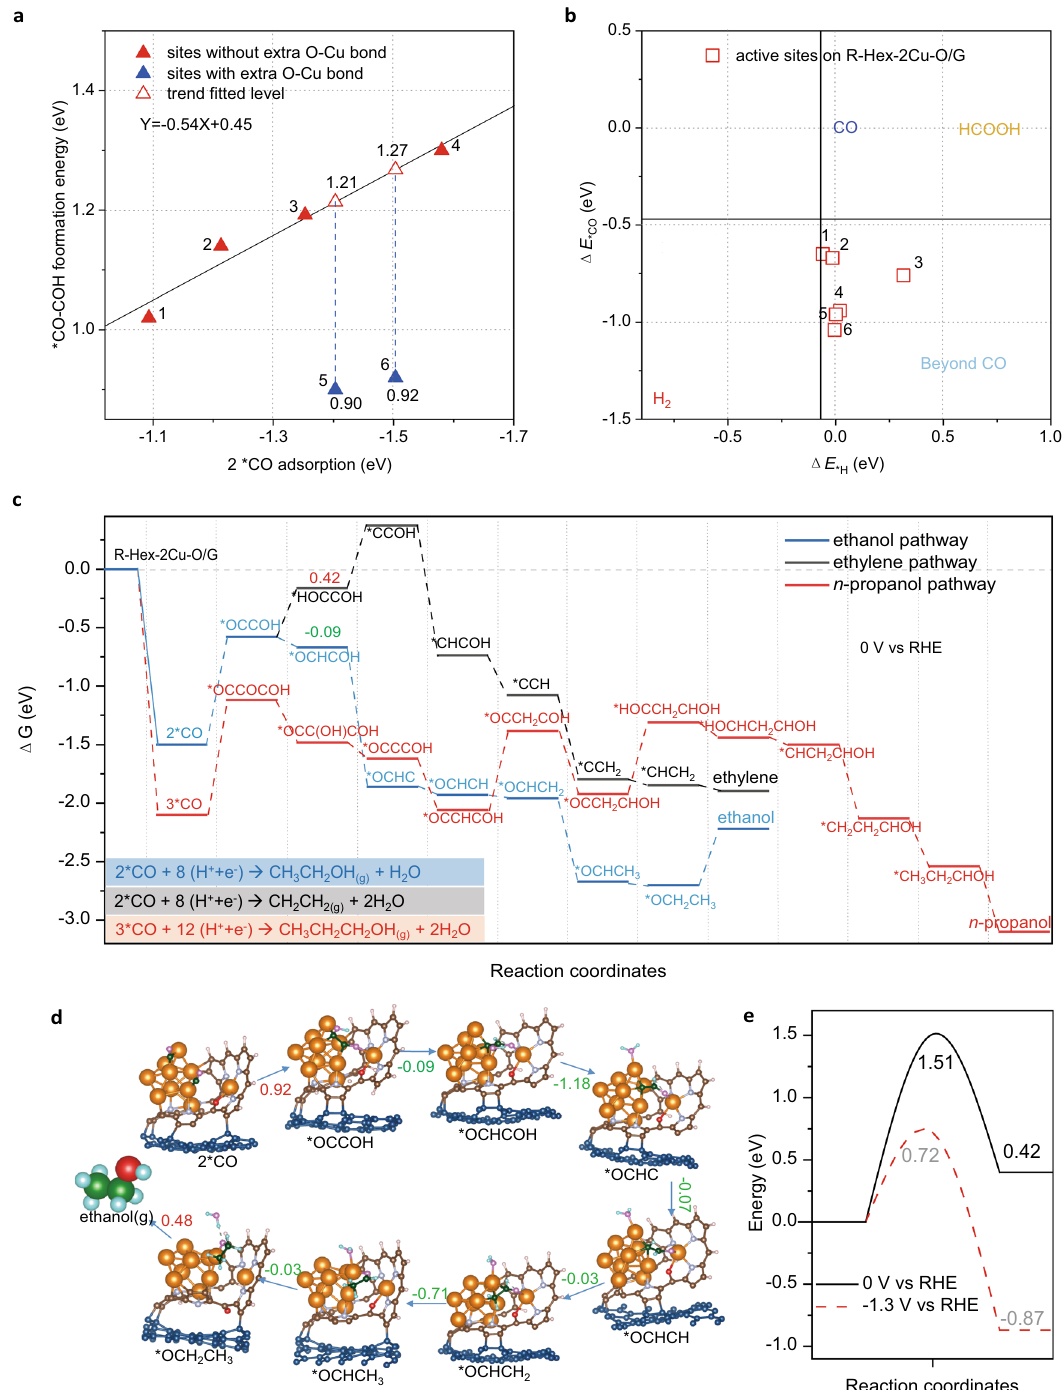
Fig. 5 | DFT calculations to unravel the formation mechanism of multi-carbon alcohols. a Linear scaling relations between 2*CO adsorption and *OCCOH for- mation free energies on R-Hex-2Cu-O/G. Atomic con fi guration of relevant active sitesaresummarizedinSupplementaryFig.35. b Analysisofadsorptionenergyfor CO ( Δ E *CO ) and H ( Δ E *H ) at various sites on the R-Hex-2Cu-2O/G. Vertical and hor- izontal black lines represent the equilibrium states (i.e., Δ G =0) for *H ↔ ½ H 2 , and *CO ↔ CO, respectively. Atomic con fi guration of relevant active sites are summar- ized in Supplementary Fig. 37. c Reduction pathways identi fi ed on R-Hex-2Cu-O/G at 0V vs RHE. The reference energy level is set to be bare surface. Free energy